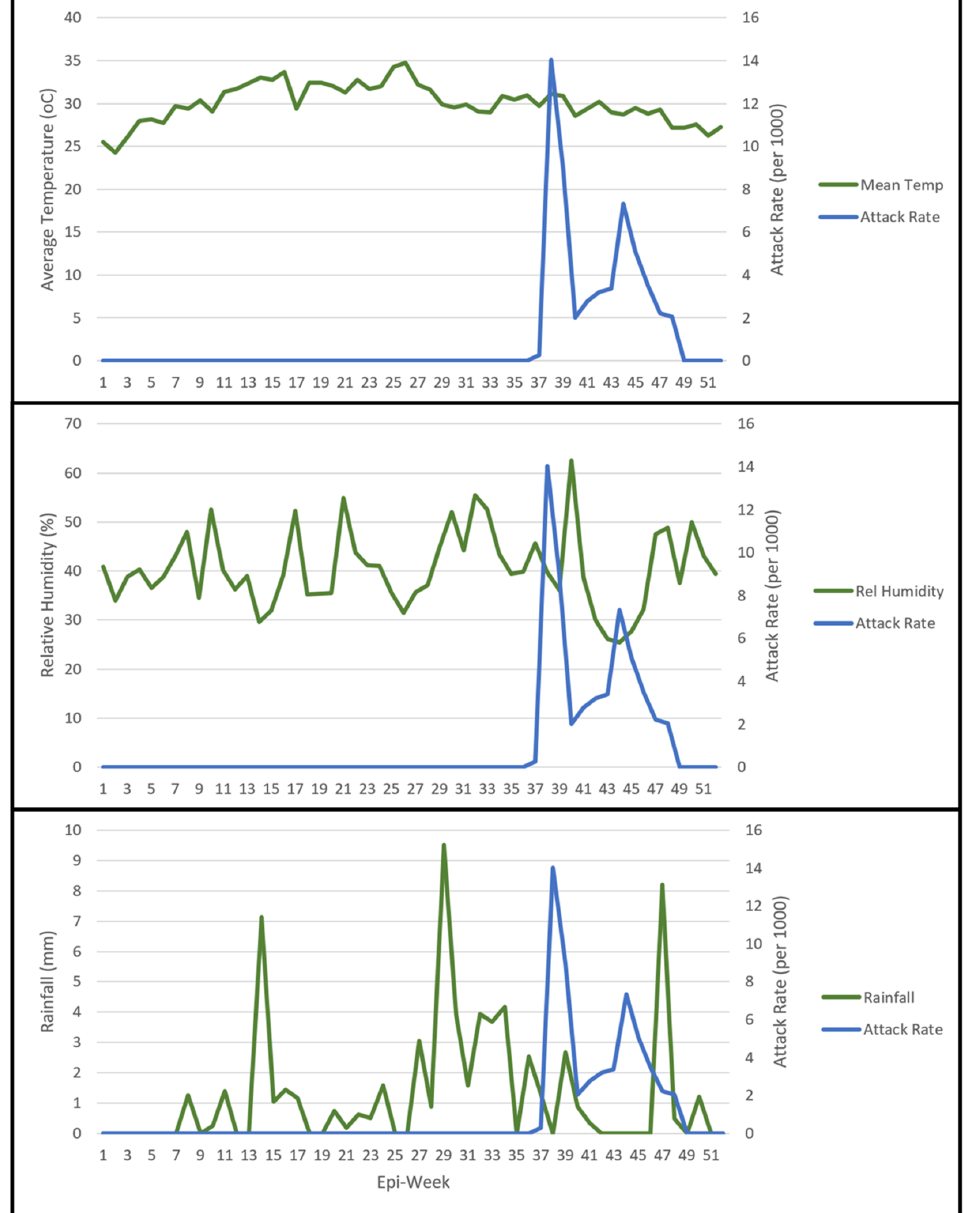
Figure 5. Climate data (mean temperature, relative humidity, and rainfall) plotted with weekly attack rate by WHO Epi-week for Gewane District for 2019.